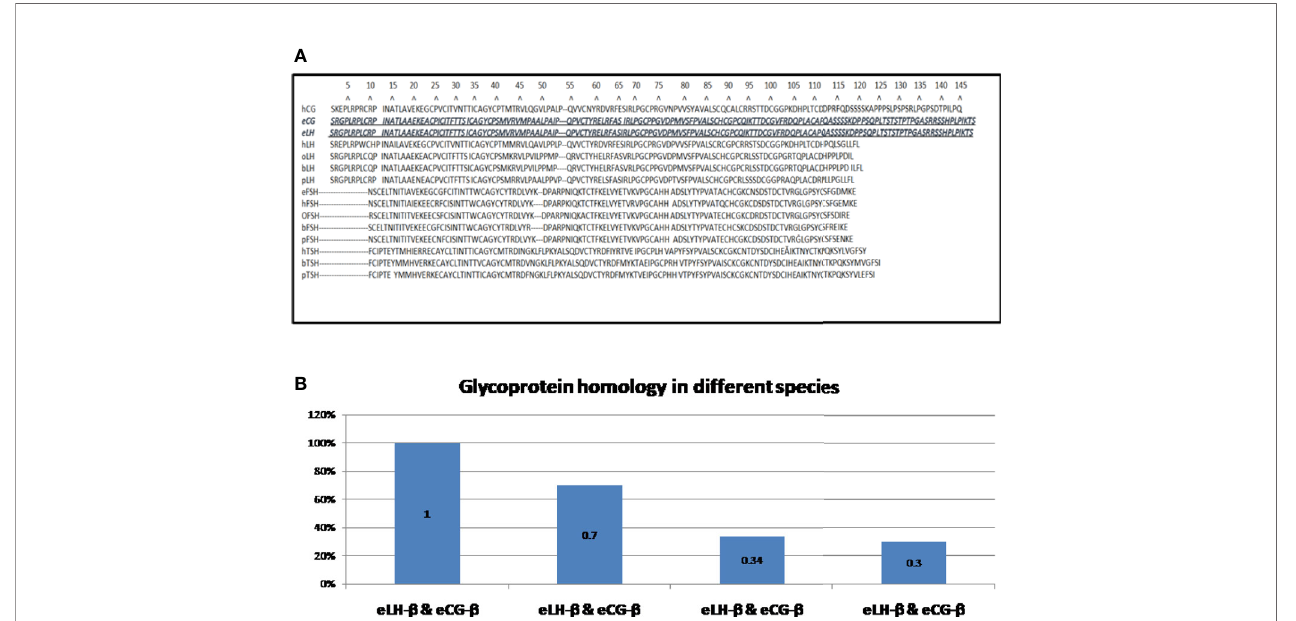
FIGURE 2 | (A) Amino acid sequences of the b -subunits of glycoprotein hormones (34): The shortest b -subunit in the family is bovine FSH- b consisting of 111 amino acids; the longest b -subunits in the family are of equine LH- b and equine CG- b consisting of 149 amino acids (equine LH- b & equine CG- b are identical) (26). h = human, e = equine, o = ovine, b = bovine, p = porcine CG = chorionic gonadotrophin; LH = luteinizing hormone; FSH = follicle-stimulating hormone; TSH = thyroid stimulating hormone. (B) . Homology of b -subunits of glycoprotein hormones. Exceptionally, the amino sequences of equine LH- b and equine CG- b are identical (26). Human LH- b and human CG- b are about 70% homologous. Ovine LH- b and ovine FSH- b are about 34% homologous. Bovine LH- b and bovine CG- b are about 30% homologous. H, human; e, equine; o, ovine; b, bovine; p, porcine; CG, chorionic gonadotrophin; LH, luteinizing hormone; FSH, follicle- stimulating hormone; TSH, thyroid stimulating